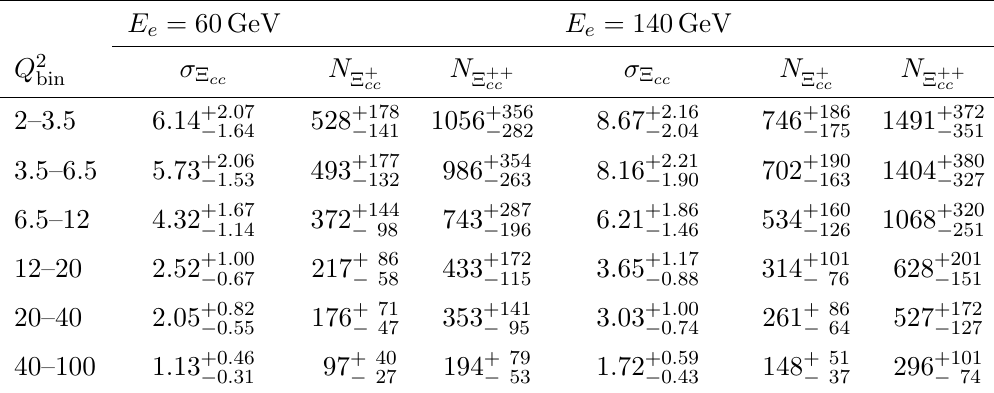
and N denote the number of the (cid:4) + (cid:4) + cc (cid:4) ++ cc ! (cid:3) + K (cid:0) (cid:25) + with (cid:3) + cc c